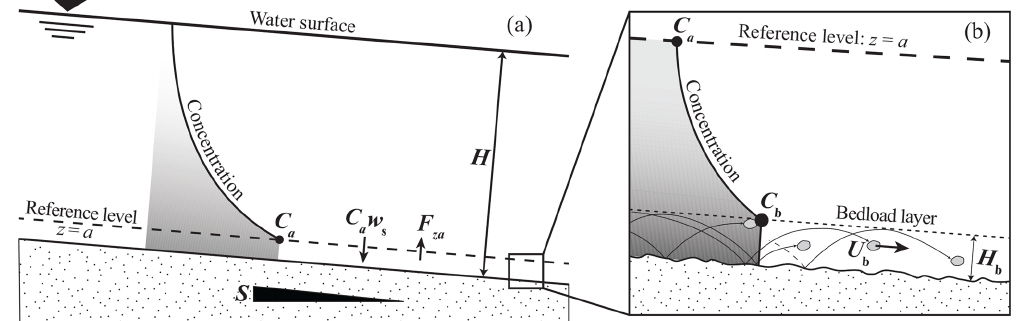
Figure 1. (a) Conceptual diagram of suspended sediment concentration–depth profile of a river of depth H and bed slope S , showing the volumetric sediment concentration, C a , settling flux per unit bed area, C a w s , and entrainment flux per unit bed area, F za , at the reference level of z = a , in which z = 0 is bed elevation. (b) Near-bed zone below the reference level showing the bedload layer with concentration C b , bedload velocity U b , and bedload-layer height H b .